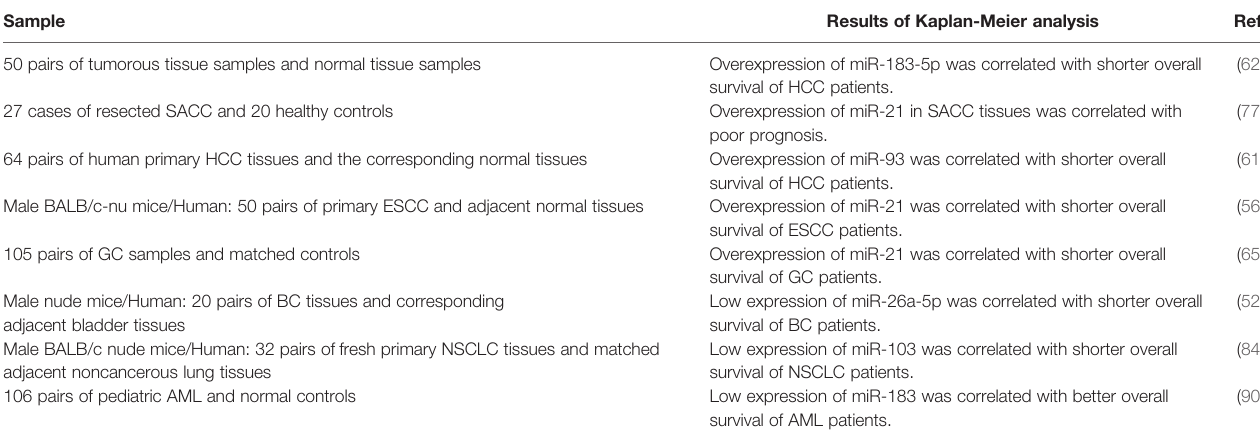
TABLE 10 | Association between PDCD-interacting miRNAs and cancer prognosis. Sample Results of Kaplan-Meier analysis